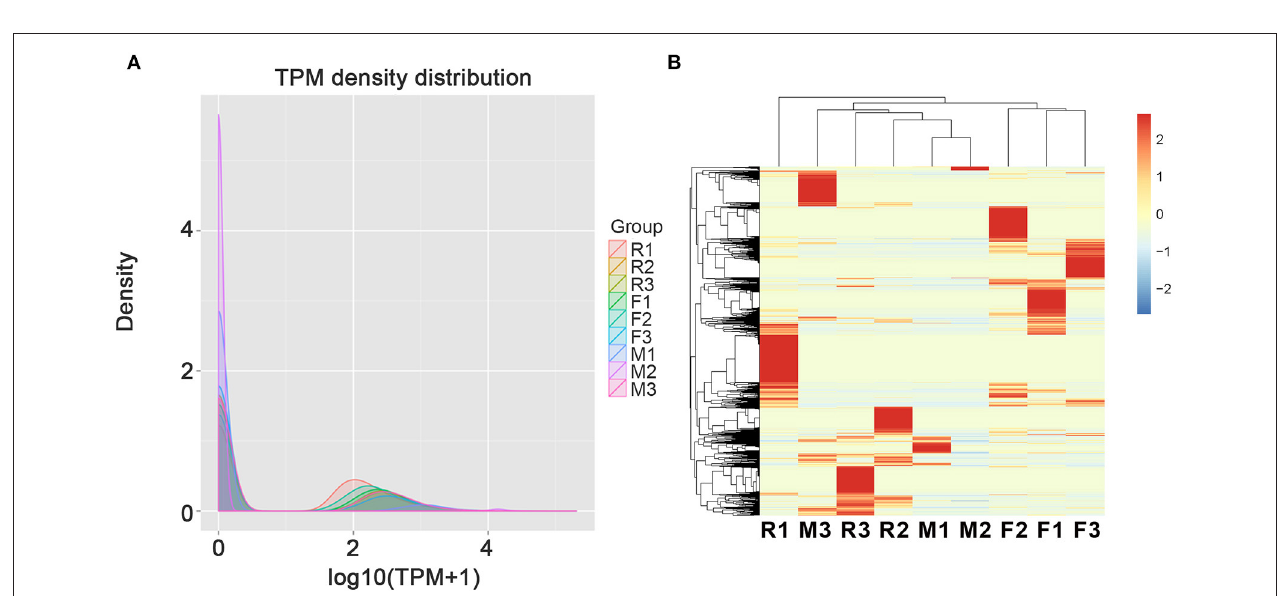
FIGURE 1 | Basic information of the sequencing results from female (F), male (M), and sex-changed (R) tilapias. (A) Proportion of the circular RNAs (circRNAs) transcribed from introns and exons from the three groups of tilapias. (B) Proportion of the circRNAs transcribed from the lncRNA, microRNA (miRNA), protein coding gene, rRNA, snRNA, and snoRNA regions in the genome.